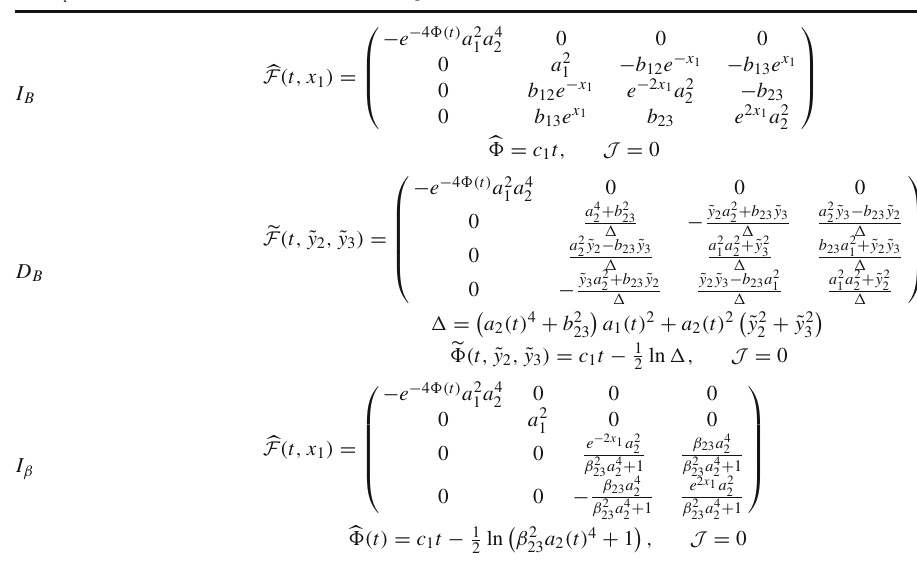
B VI − 1 Transformed backgrounds, dilatons and vectors